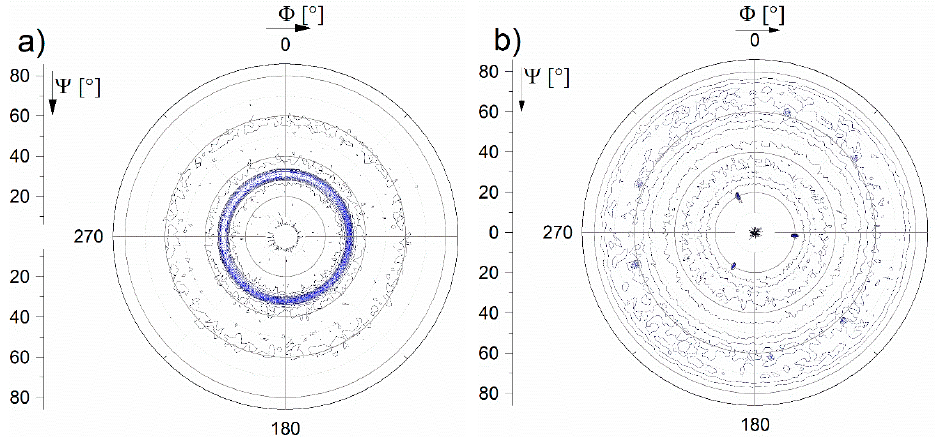
Figure 4. Pole figures obtained from films grown at T sub = 450 °C on ( a ) a Si substrate using the (422) reflection from C15 Laves phase at 2 θ = 64.4° (0–6° psi were omitted due to strong reflection in the centre), and ( b ) an Al 2 O 3 substrate using the (214) reflection from the C14 Laves phase (2 θ = 68°).